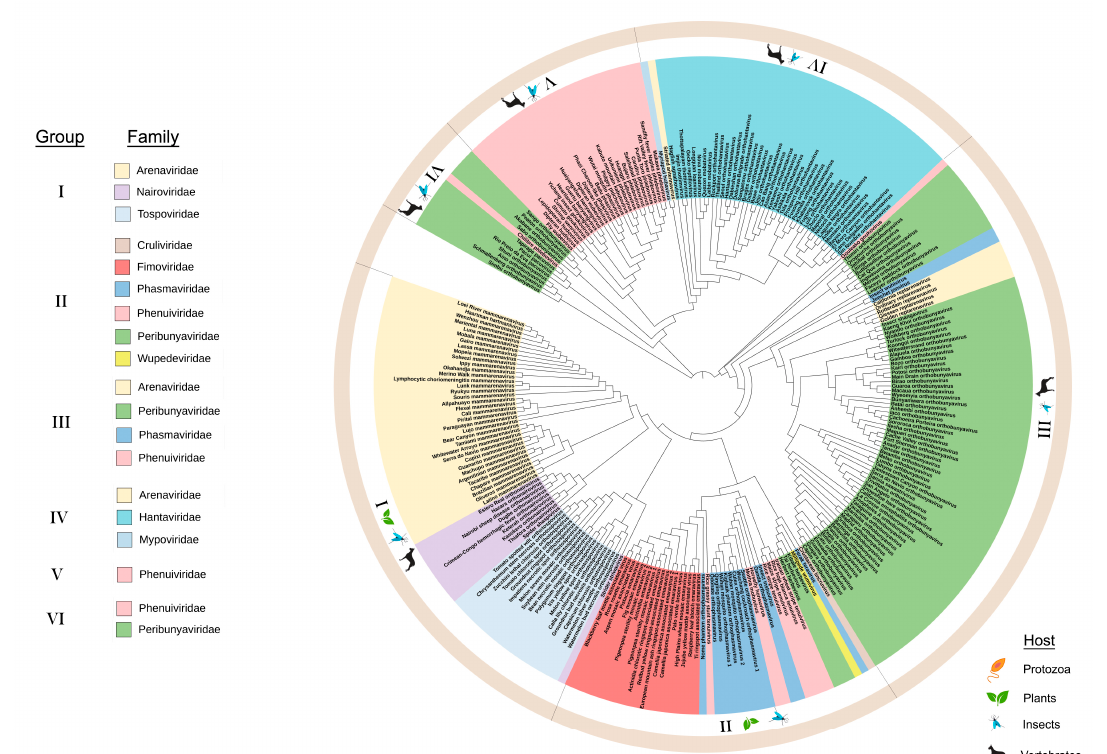
Figure 3. Maximum likelihood phylogenetic tree of the amino acid sequences of the glycoprotein precursor(preGP).Sixgroupswereidentifiedbasedonclusteringfromthemostdistantnode. Thelegend identifies the lineage groups and colors used to identify taxonomic families as in Figure 1. Group I: Arenaviridae , Nairoviridae and Tospoviridae . Group II: Cruliviridae , Fimoviridae , Phasmaviridae , Phenuiviridae , Peribunyaviridae , and Wupedeviridae. Group III: Arenaviridae , Peribunyaviridae , Phasmaviridae , and Phenulviridae . Group IV: Arenaviridae , Hantaviridae , and Mypoviridae . Group V: Phenuiviridae . Group VI: Phenuiviridae and Peribunyaviridae . Families are color-coded and the hosts for viruses within each group are indicated in the outermost circle. Clade validation is based on the